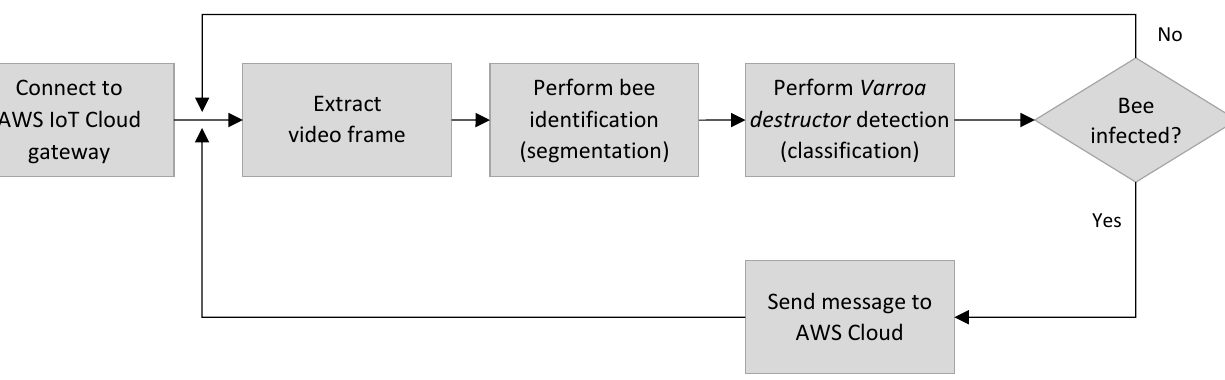
Figure 2. A software organisation for the Varroa destructor detection performed on the Edge IoT